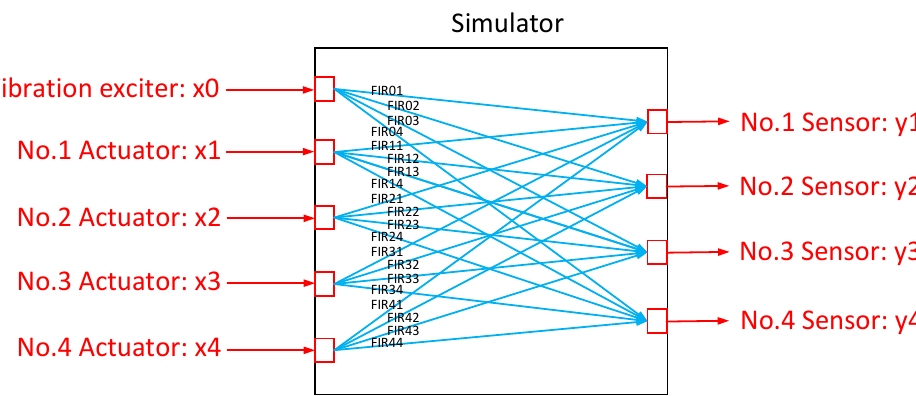
Figure 2. Depiction of the simulator for the vibration system. The simulator, which has enough physical fidelity, receives force signals and outputs acceleration signals.